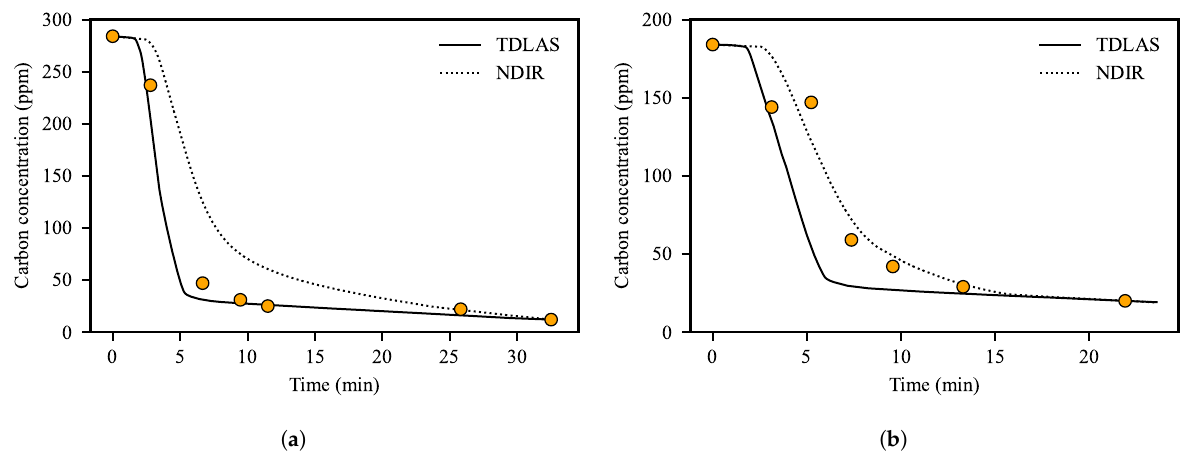
Figure 4. Comparison of the decarburization curves and the actual carbon concentrations (filled circles). Operations ( a ) without or ( b ) with additional carbon. The solid and dotted lines represent the decarburization curves obtained using TDLAS and NDIR analyzers,